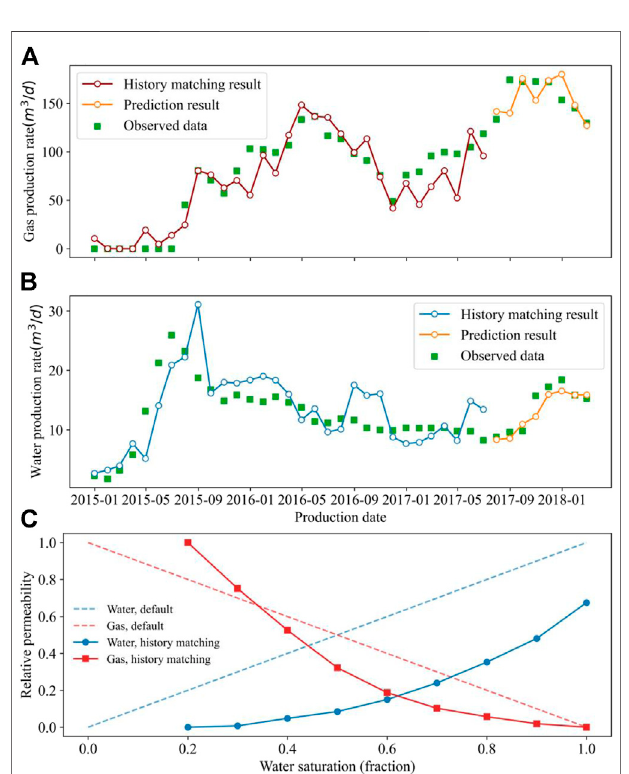
Frontiers in Earth Science |